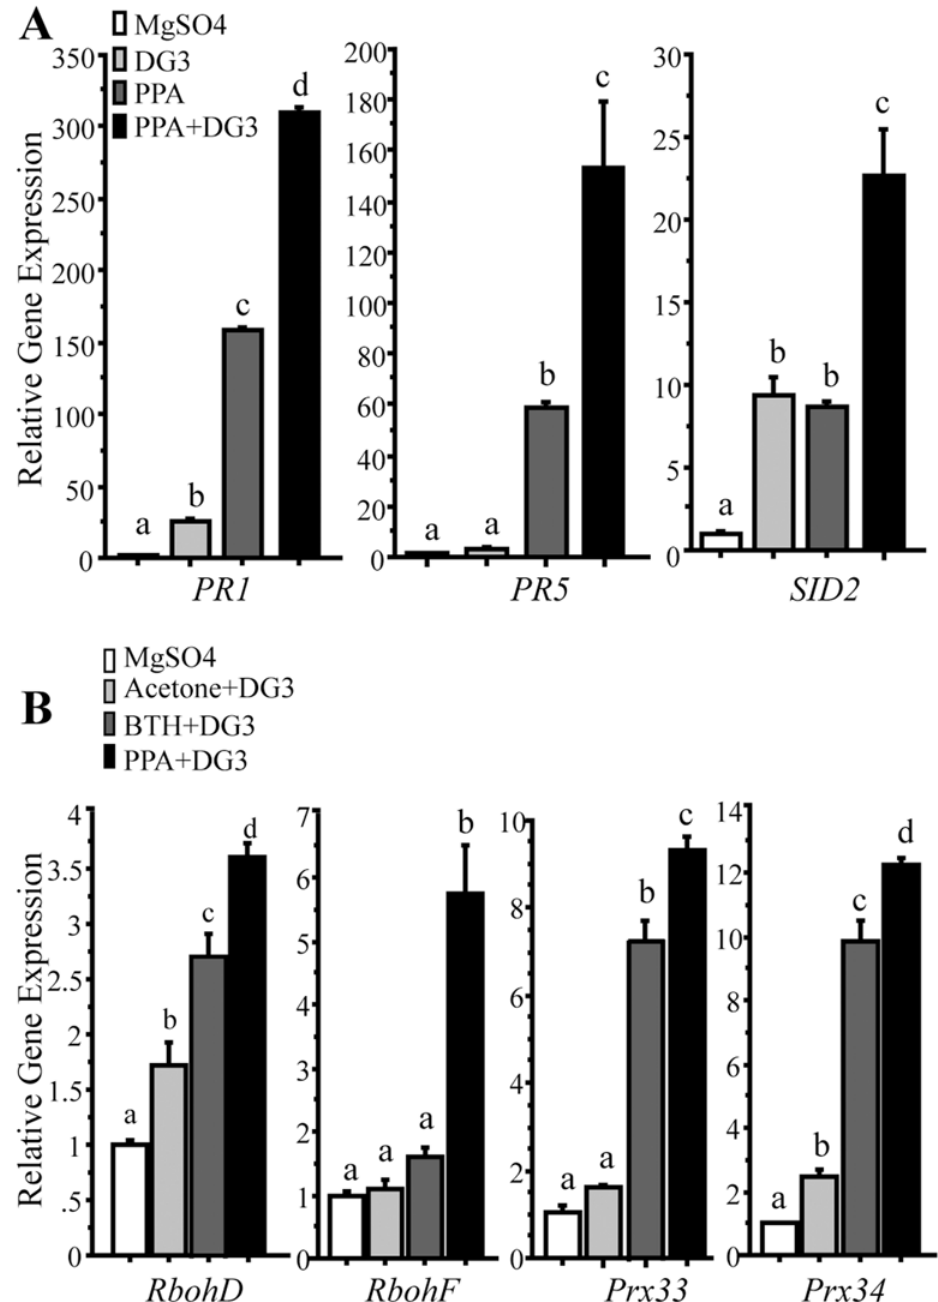
Fig 4. Defense and ROS related gene expression in PPA-pretreated leaves infected with bacteria. Nineteen-day-old leaves pretreated with 40 μ M PPA ( A and B ) for 2 days and 100 μ M BTH ( B ) for 3 days, then infiltrated with 10 mM MgSO 4 , 0.3% acetone (solvent of BTH) and DG3 (OD 600 = 0.005) for 12 h. Total RNA was extracted for qRT-PCR. ACT2 (At3g18780) was used as an internal control. Gene expression values are presented relative to average MgSO 4 treated leaf levels (set as 1). Error bars represent the means ± SE from triplicate reactions in each experiment. Data sets marked with different letters indicate significant differences (P < 0.05, PLSD-test). This experiment was repeated three times with similar results. The primers used for this analysis are provided in S3